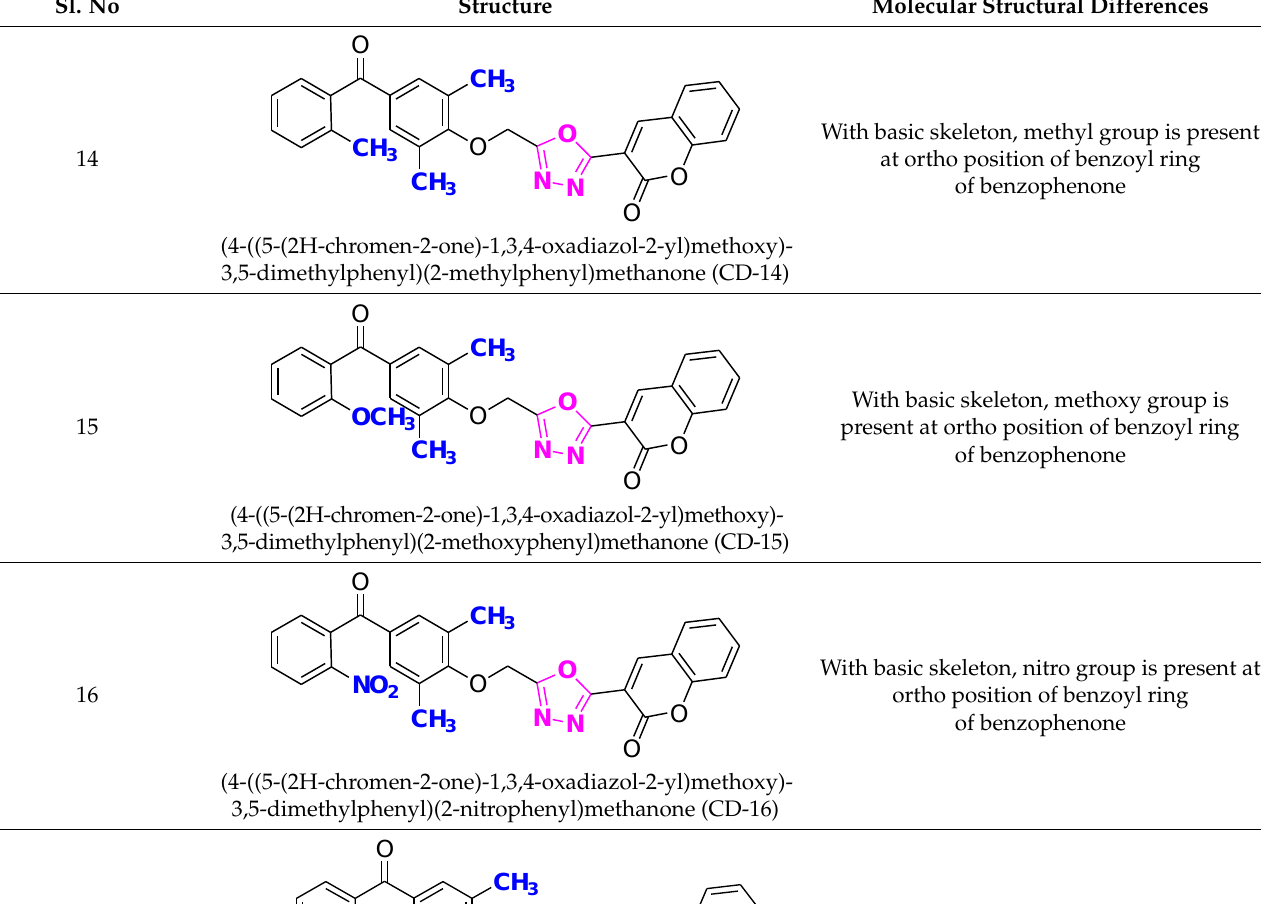
With basic skeleton, methyl group is present at ortho position of benzoyl ring of